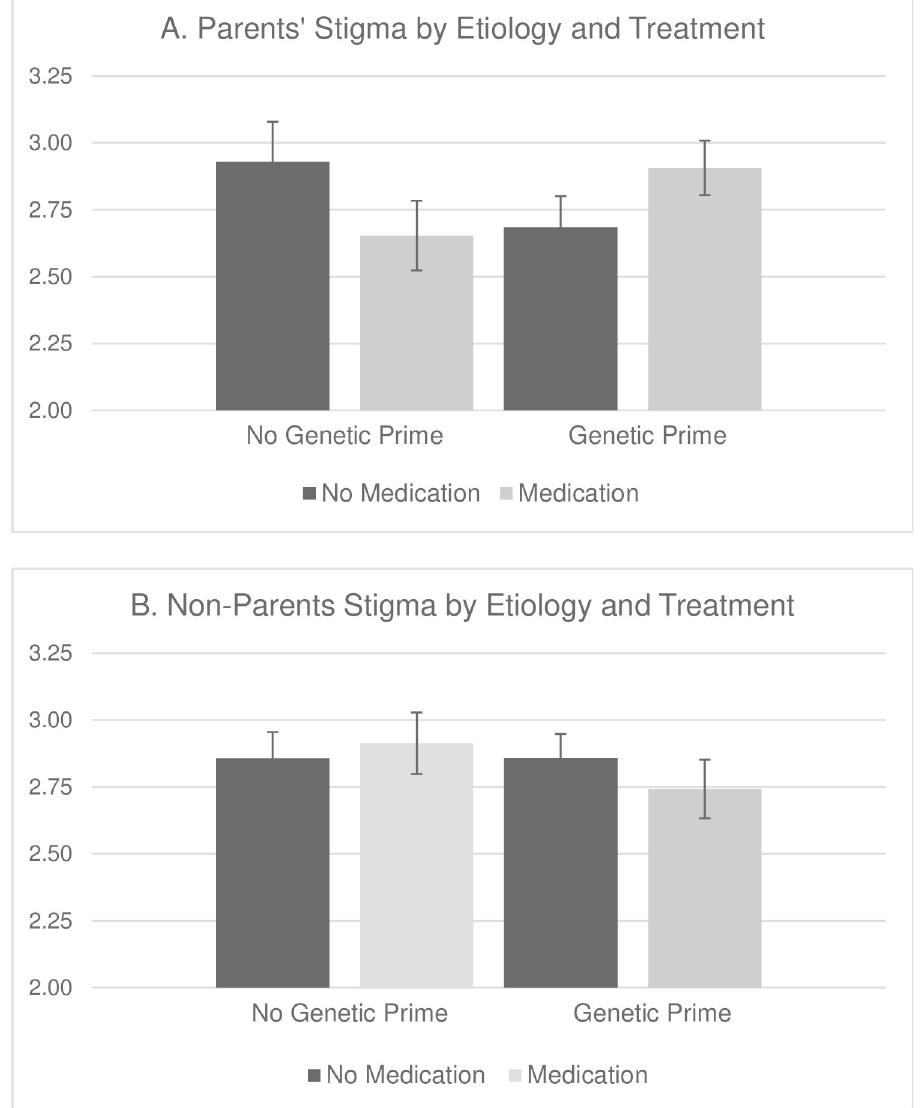
Fig 1. Stigmatizing Attitudes as a Function of Etiology and Treatment for Parents (A) and Non-Parents (B). To investigate the three-way interaction and examine differences among parents and non- parents, we conducted 2 (genetic prime v. no genetic prime) x 2 (medication v. no medication) ANOVAs for parents and non-parents separately. For parents, a two-way interaction emerged between genetic prime and treatment, F (1, 155) = 4.08, p = .045, η 2 = .03, as shown in Fig 1A . This interaction reveals that parents reported greater stigma when the cause of the child’s con- dition matched what is perceived to be the appropriate treatment. Congruent conditions (i.e., medication used in the genetic prime condition and no medications used in the no genetic prime condition) did not significantly differ from one another, t (155) = .13, p > .50. Likewise, non-congruent conditions (i.e., no medication used in the genetic prime condition and medi- cation used in the no genetic prime condition) did not significantly differ from one another, t (155) = .18, p > .50; however, the congruent and non-congruent conditions were significantly